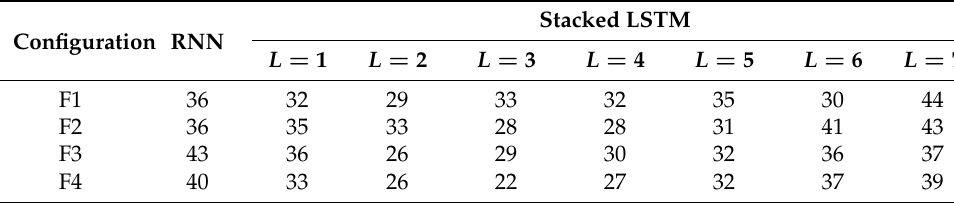
Table 10. The average mean error of t exact for both stacked LSTM and RNN.